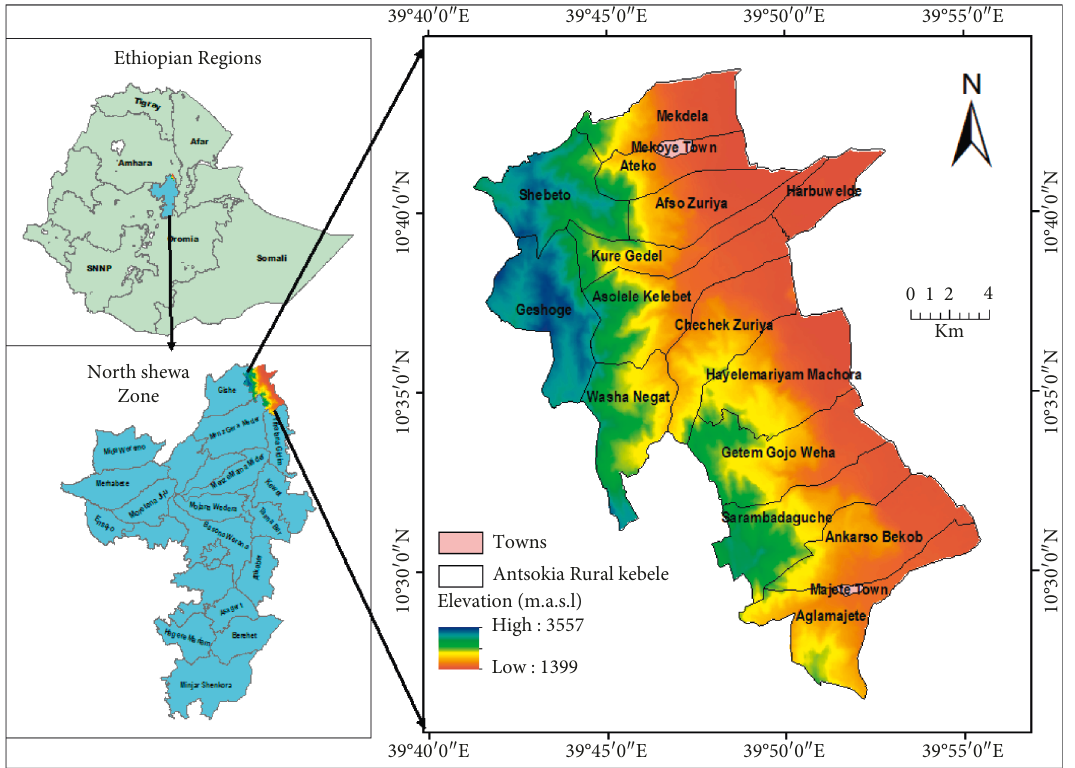
Figure 1: Location map of the study